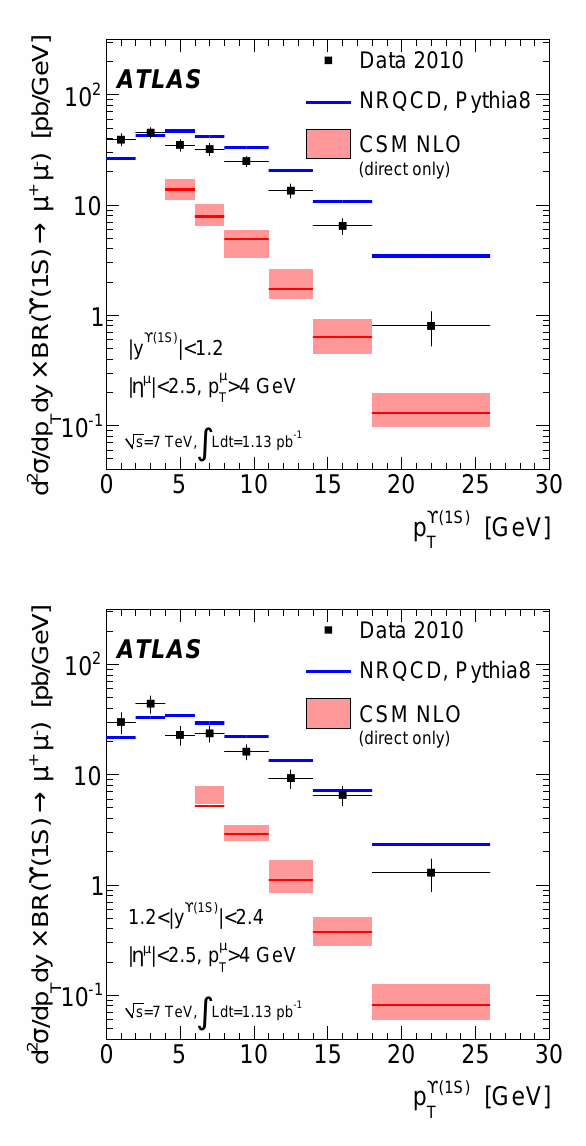
µ + µ − production cross- Fig. 5. Di ff erential prompt Υ (1 S ) → y Υ (1 S ) < 1 . 2 (top) and 1 . 2 < y Υ (1 S ) < 2 . 4 (bottom) section for | | | | > 4 GeV, η µ < 2 . 5. Comparison as function of p Υ (1 S ) for p µ T T | | is made to colour-singlet NLO direct production predictions, and the shaded area shows the change in the theoretical prediction when varying the renormalisation and factorisation scales by a factor of two. A comparison is also made to a model based on NRQCD native to P ythia 8, for a particular choice of parameters.